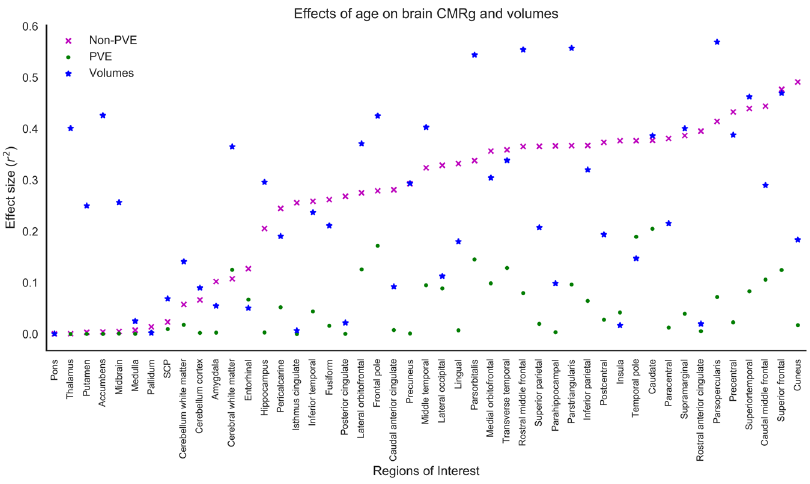
Figure 1. Plot of non-partial volume effect (PVE) and PVE corrected cerebral metabolic rate of glucose (CMRg) and volume effect size ( r 2 ). Plot is arranged in increasing order of r 2 for each FreeSurfer region of